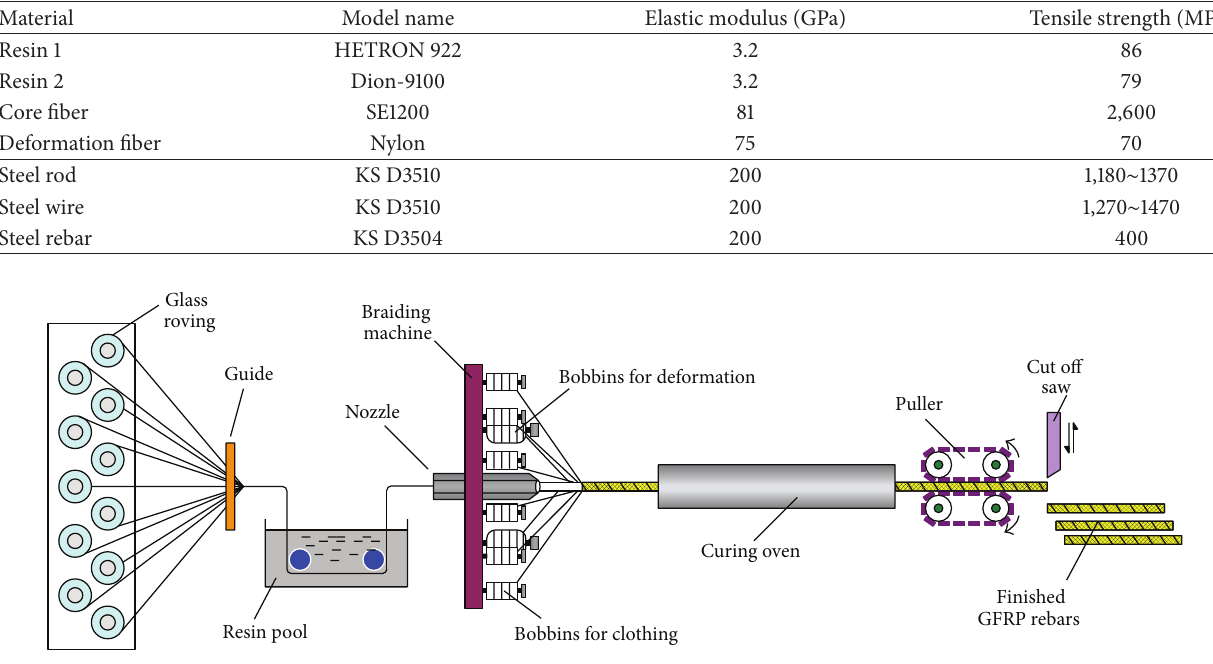
Figure 4: Modified braidtrusion process